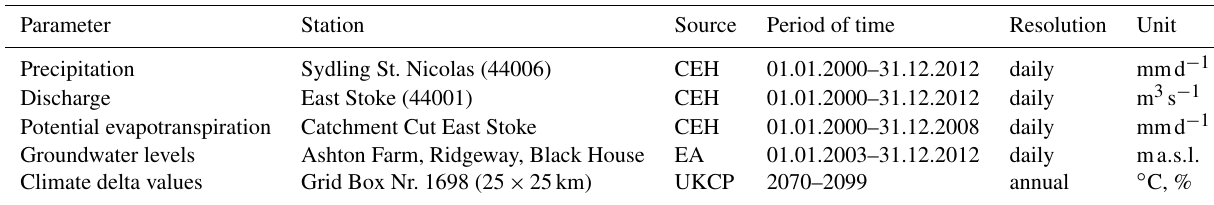
Table 1. All available data used in the study. Parameter